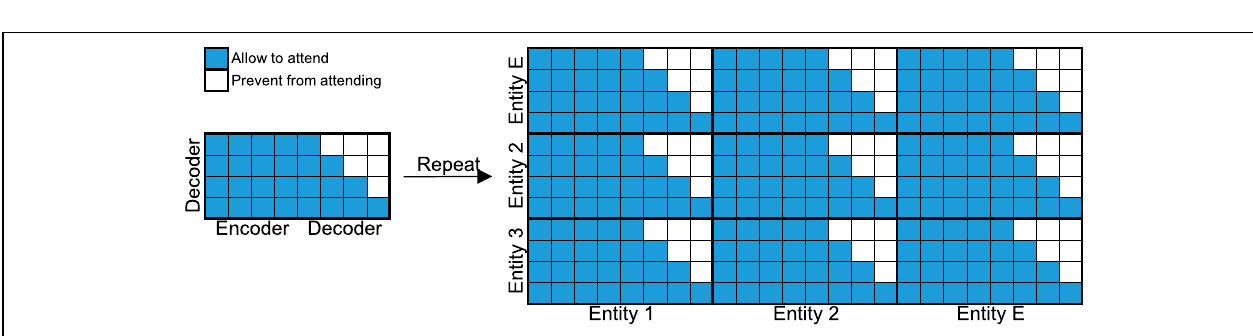
FIGURE 3 | Left: The original self-attention mask for TFT. Right: The cross-entity attention mask for CETFT, generated by repeating the single-entity attention mask by E times both horizontally and vertically.